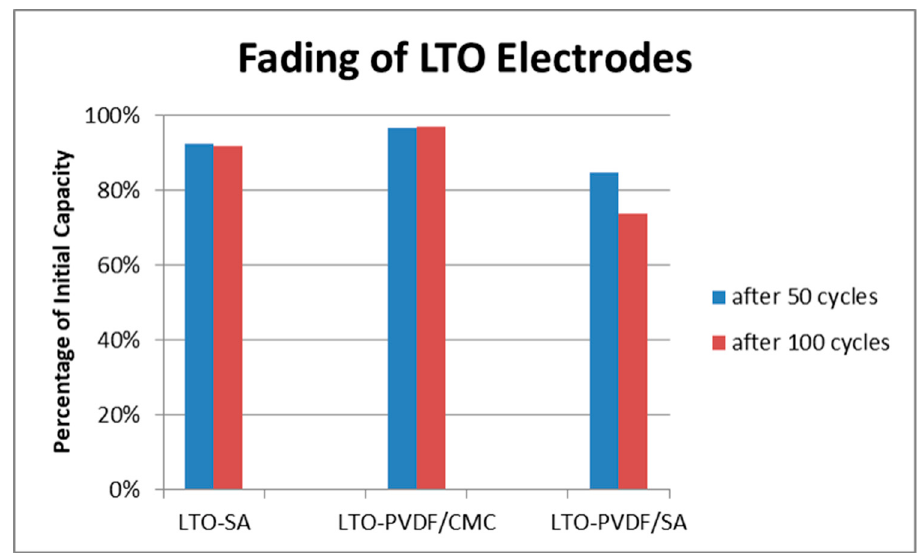
Figure 10. Fading of LTO electrodes with different binders.